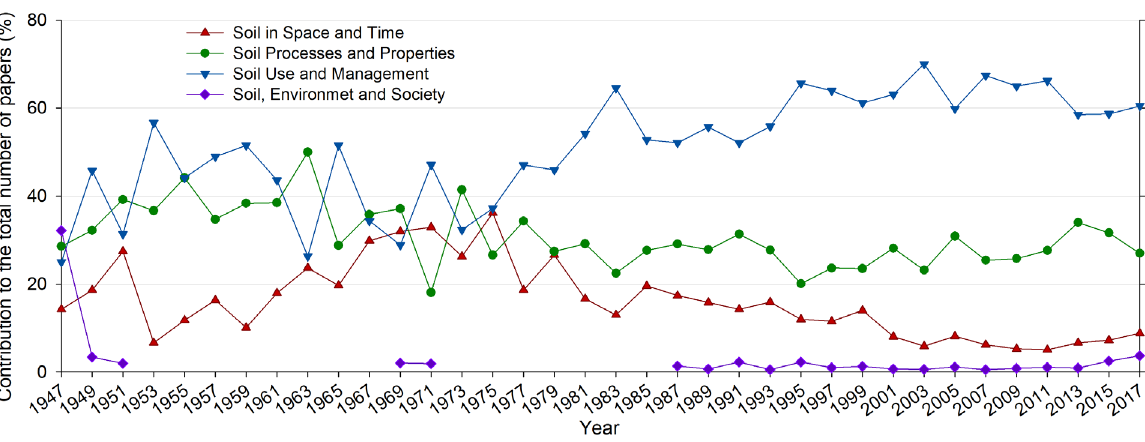
Figure 3. Percentage contribution of each division that currently compose the scientific structure of the Brazilian Society of Soil Science (Sociedade Brasileira de Ciência do Solo - SBCS) to the total number of papers of each Brazilian Congress of Soil Science (Congresso Brasileiro de Ciência do Solo - CBCS) between 1947 and